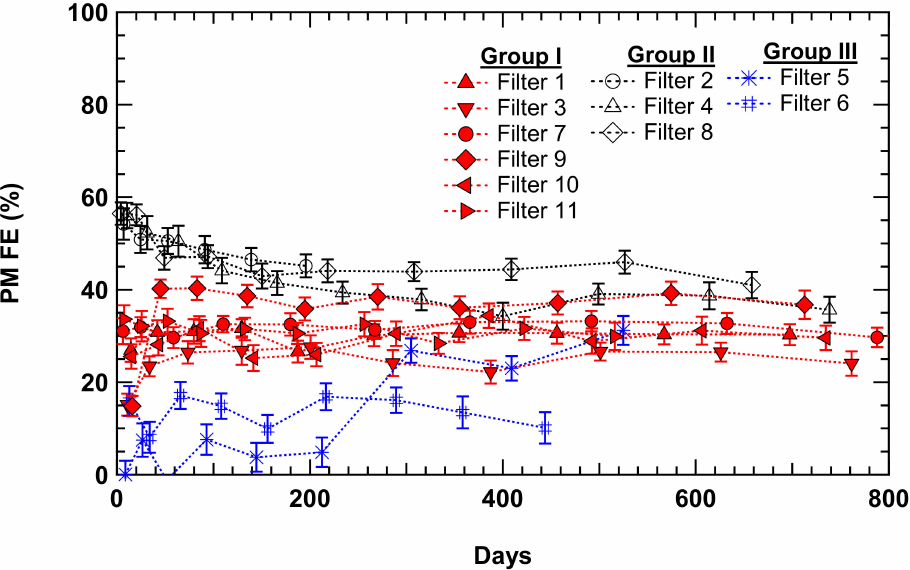
Figure 10. Particulate matter mass filtration efficiency over time for Group I (normal filters), Group II (electrostatic filters), and Group III (underperforming